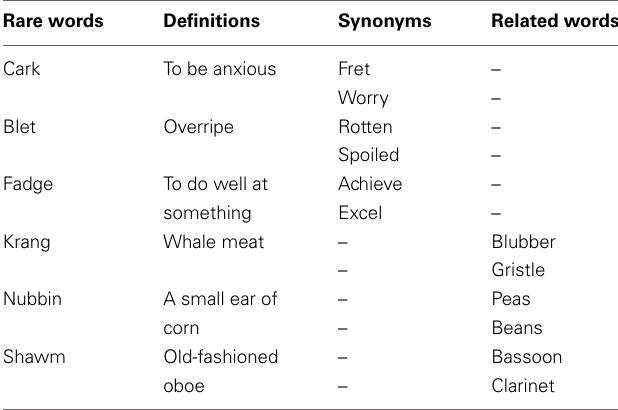
Table 1 | Examples of rare words, synonyms, and related words used as